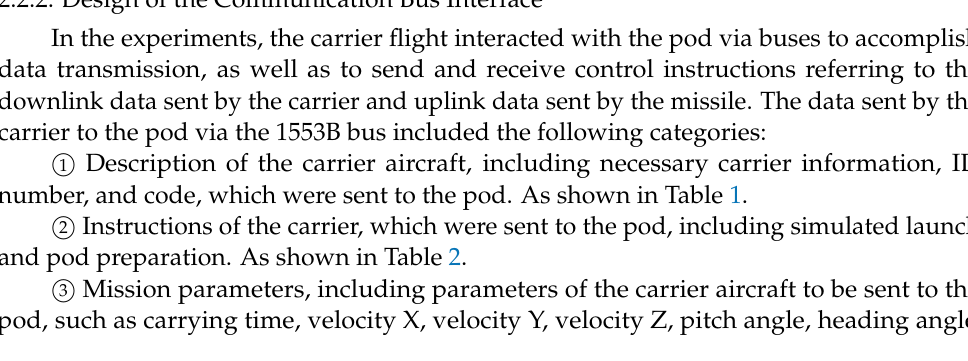
Figure 5. Metallographic morphology of the transverse and longitudinal structure of the “T”-shaped structure.